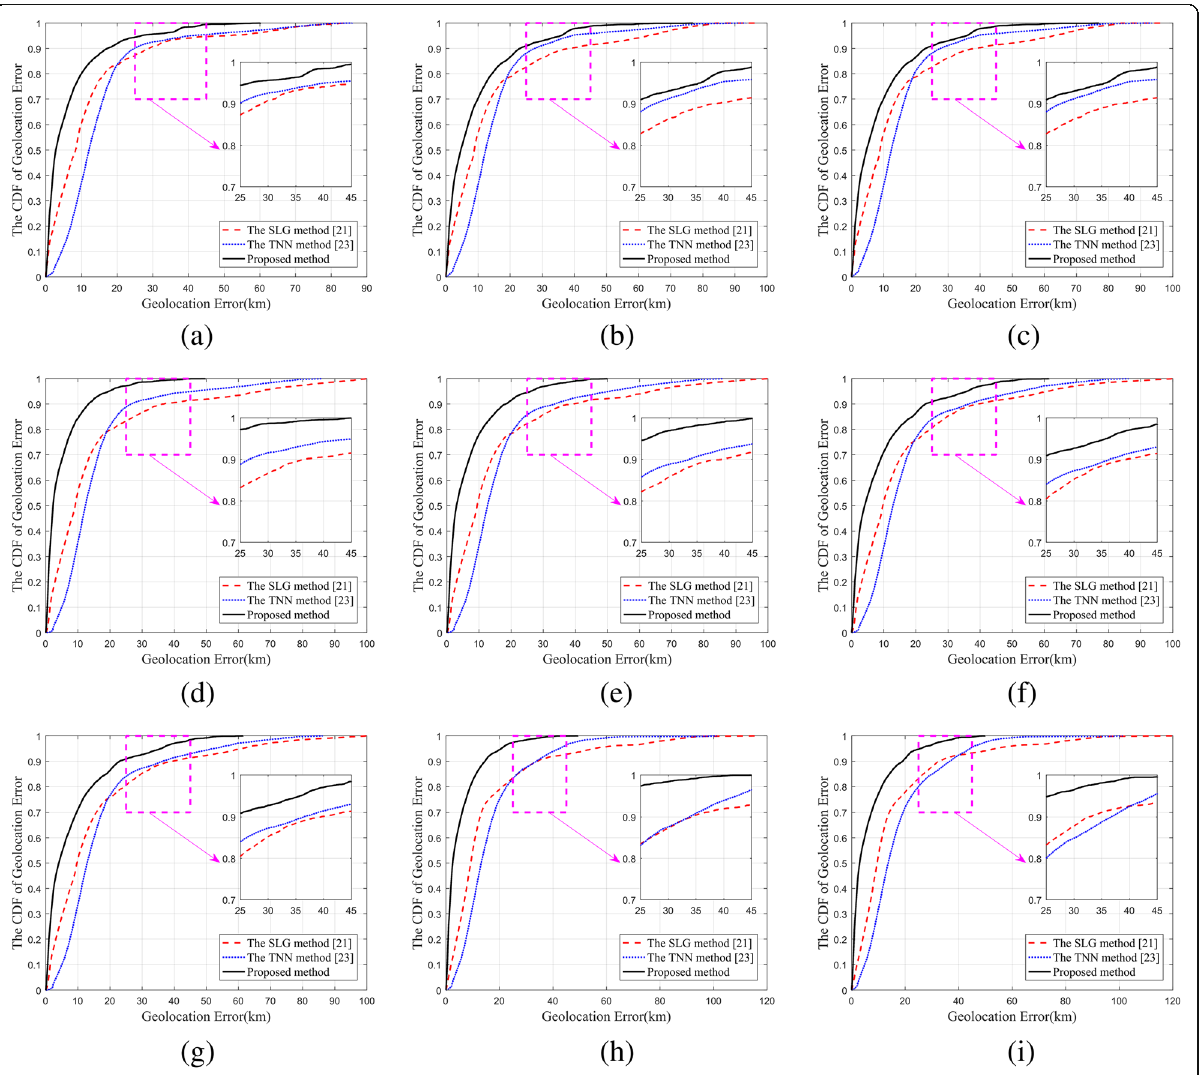
Fig. 5 Comparison on IP geolocation error under the same conditions. The black line, red dashed line, and blue dot line indicate the geolocation error cumulative distribution of the proposed method, SLG method, and TNN method, respectively. a The training set size > 100, and the threshold is 0.9. b The training set size > 100, and the threshold is 0.8. c The training set size > 100, and the threshold is 0.7. d The training set size > 300, and the threshold is 0.9. e The training set size > 300, and the threshold is 0.8. f The training set size > 300, and the threshold is 0.7. g The training set size > 500, and the threshold is 0.9. h The training set size > 500, and the threshold is 0.8. i The training set size > 500, and the threshold is